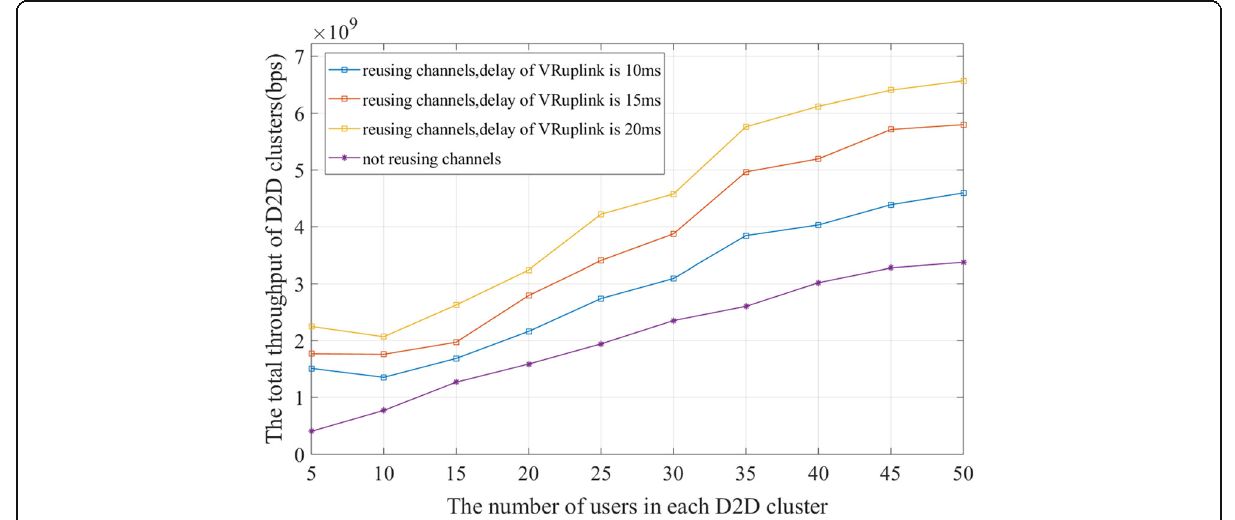
Fig. 4 The effect of changing the number of users in the D2D clusters on the total throughput of the D2D